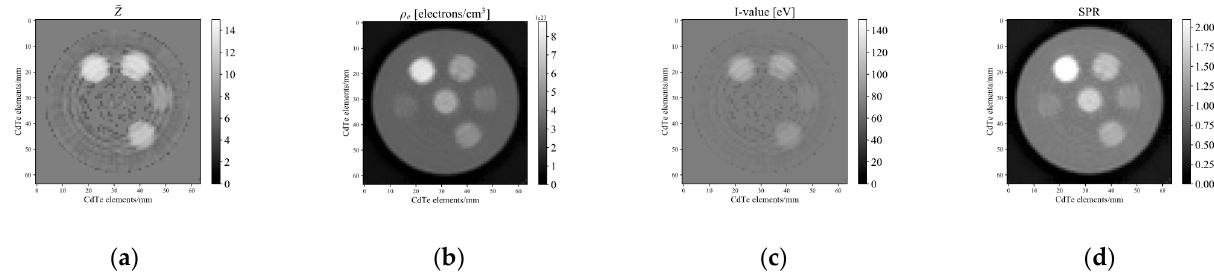
Figure 9. Maps calculated via two-PFM for ( a ) effective atomic number, ( b ) electron density, ( c ) I -value, and ( d ) SPR. The I -values were parameterised using the fitting curve of the mixture in Figure 4, calculated using the Bragg additivity rule.